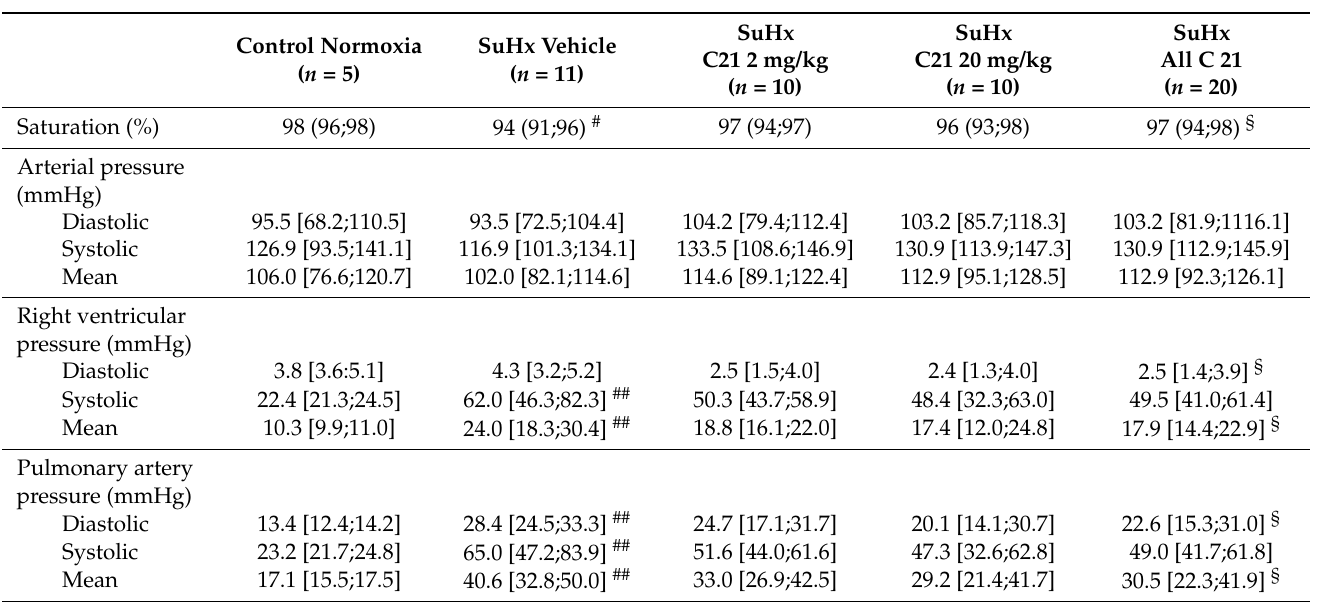
Table A2. Hemodynamic assessments by catheterization on day